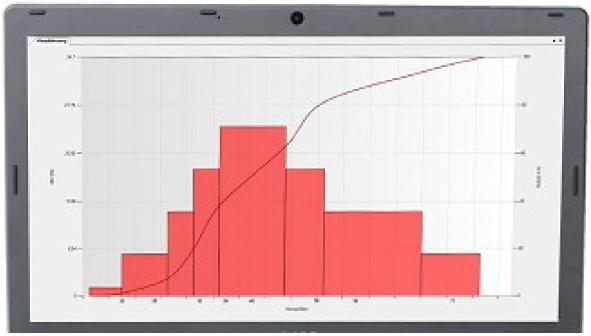
Figure 2. Image of the analysis of the performed measurements on the computer